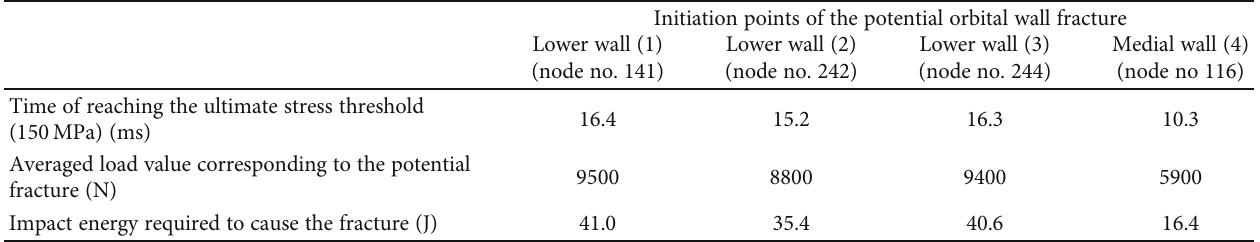
Figure 8: Potential orbital fracture individual initiation points. H-M-H stress distribution (Pa) without the deformation within the analyzed thin shell skull part during time t = 18 : 5ms (MOBOSE). Table 2: Summary of the nonlinear transient analysis regarding the contact problem